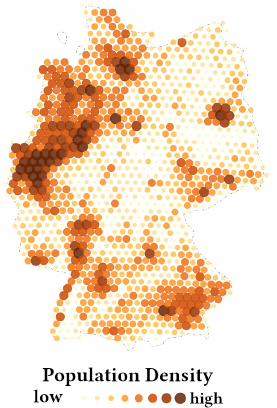
Figure 2. The study area of Germany and its population density. Small light yellow dots represent a low population density, whereas large dark brown dots show areas with high population densities. The population data were aggregated according to hexagons 20 km-wide derived from the GHSL Data Package 2019